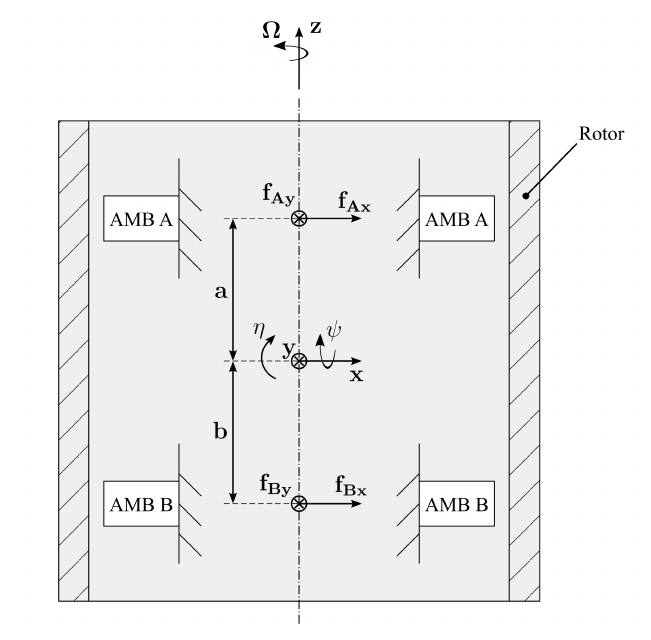
Figure 7. Schematic of the rigid rotor on AMBs. Table 4. Mechanical parameters of the